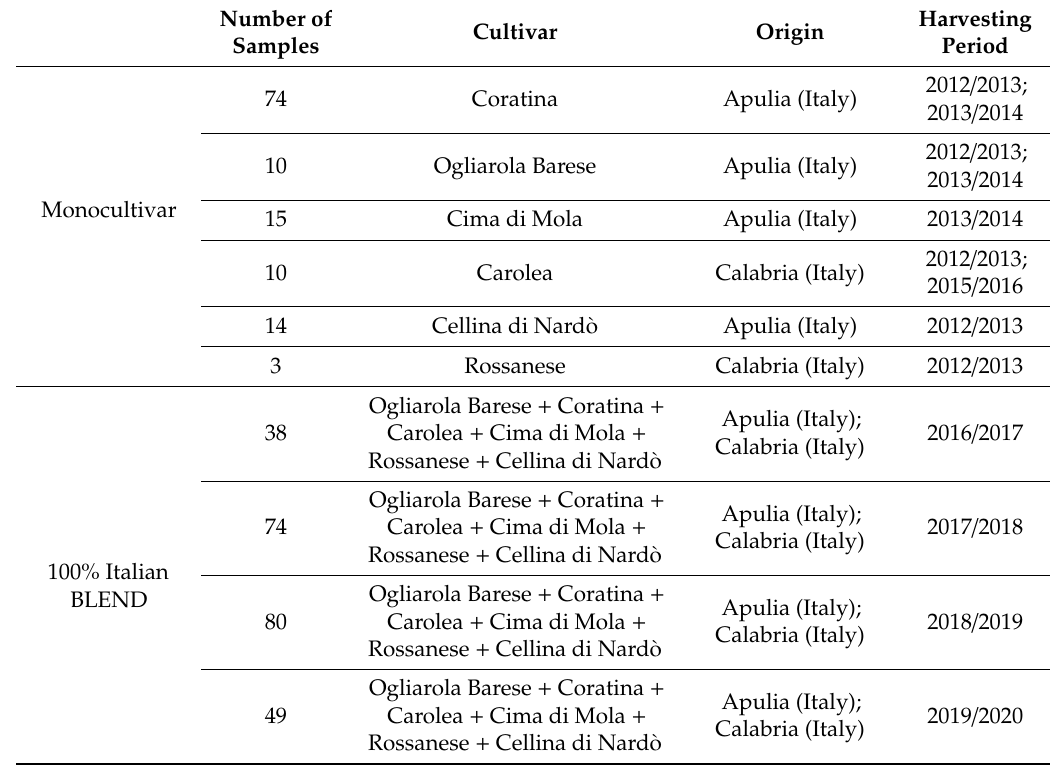
Table 1. List of analyzed monocultivar and blend